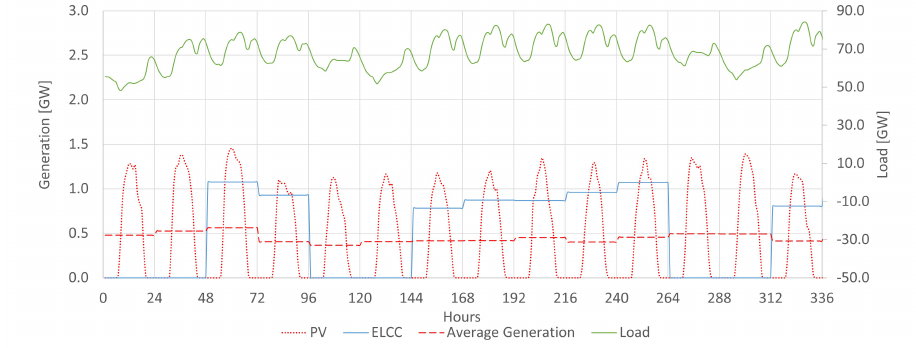
Figure 10. Load, PV generation and ELCC in an hourly basis for the first two weeks of 2019.